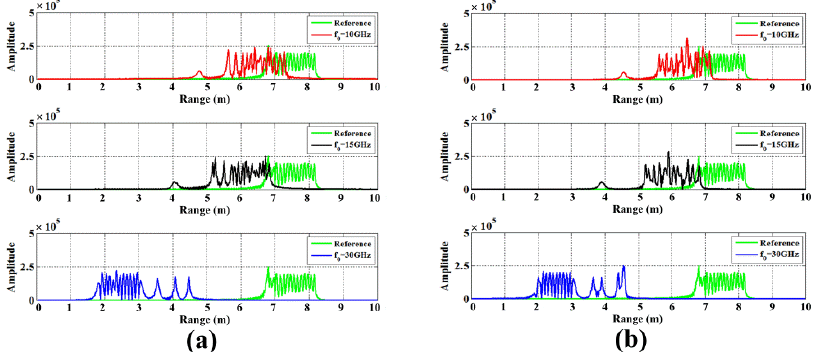
Figure 19. One dimensional range profiles of the hypersonic target in scenes 6 and 7. ( a ) Attack angle is 10°. ( b ) Attack angle is 20°.